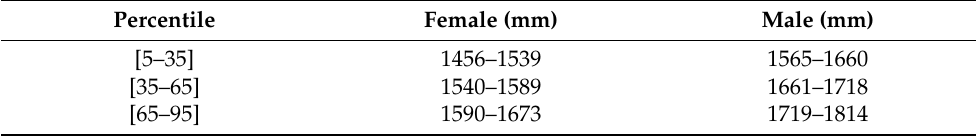
Table 4. Stature percentile classes for female and male.